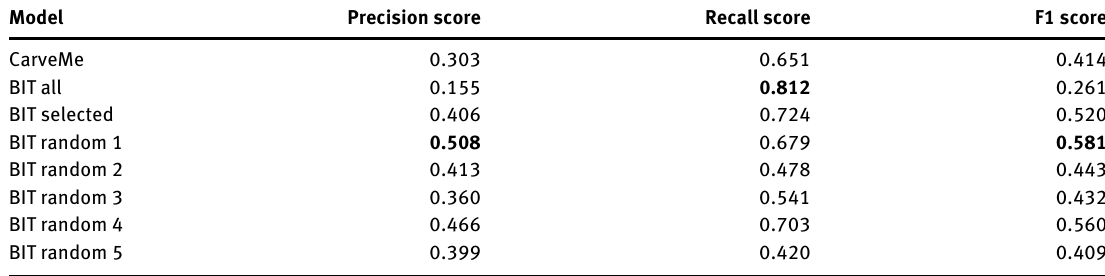
Table 2: Comparison of the evaluation metrics between draft models generated with CarveMe and with BIT for S. thermophilus . Model Precision score